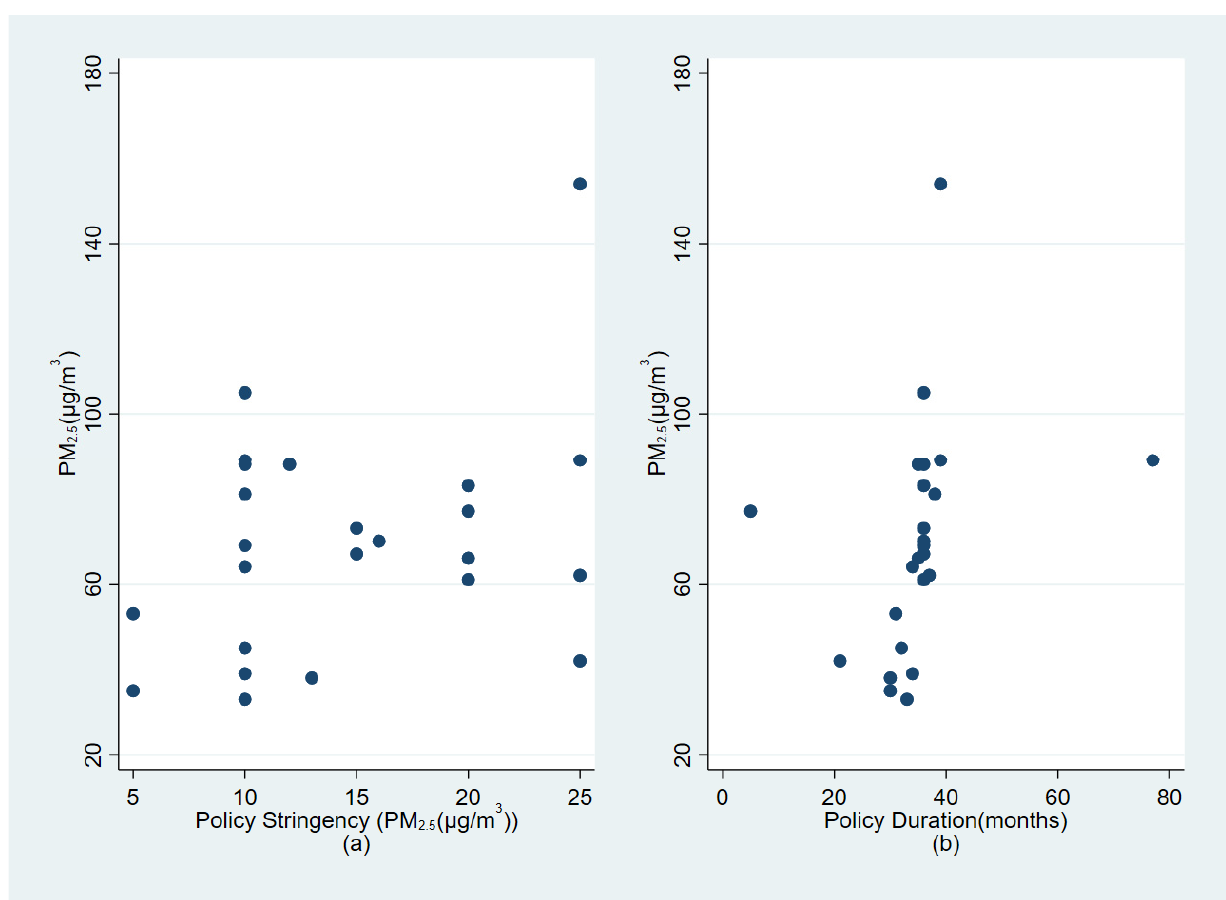
Figure 2. Policy characteristics and air pollution levels before the intervention. Notes : The y -axis represents PM 2.5 concentrations in the year before policy intervention. ( a ) The x -axis represents the policy stringency measured by the difference between the pre-intervention level of PM 2.5 and the goal level of PM 2.5 . For example, the pre-intervention level of PM 2.5 for Sichuan was 65 μ g/m 3 , and the goal level of PM 2.5 was 55 µ g/m 3 , which is 10 µ g/m 3 (=65 − 55); ( b ) the x -axis represents the duration of the policy in months. Table 6. Logit estimates: stringency of APPCAP on chronic